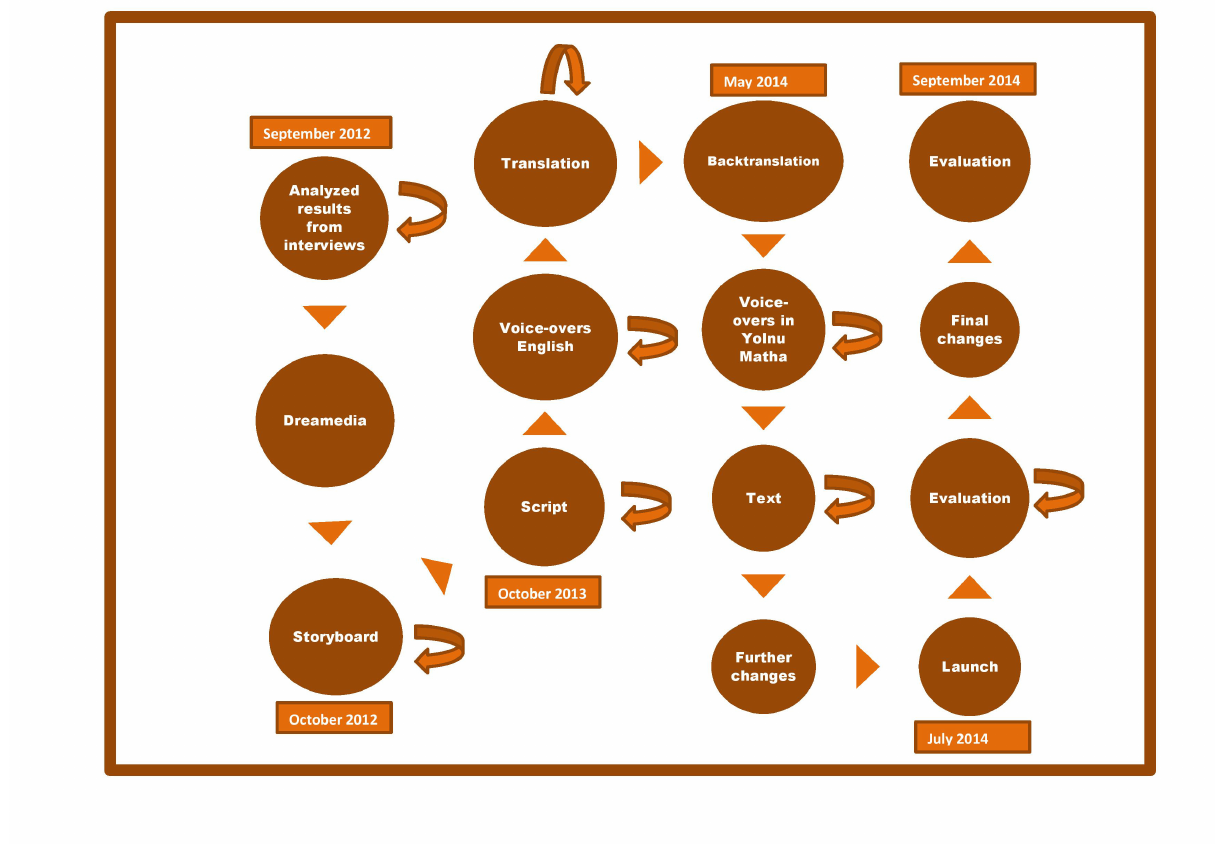
Figure 1. Major stages and timelines for the development of the Hep B Story electronic app. Curved arrows represent time points where episodes of community consultation